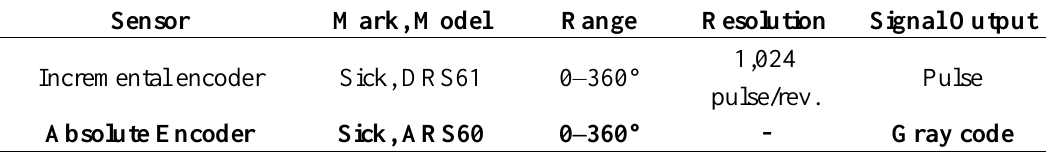
Table 1. Features of the installed sensors.